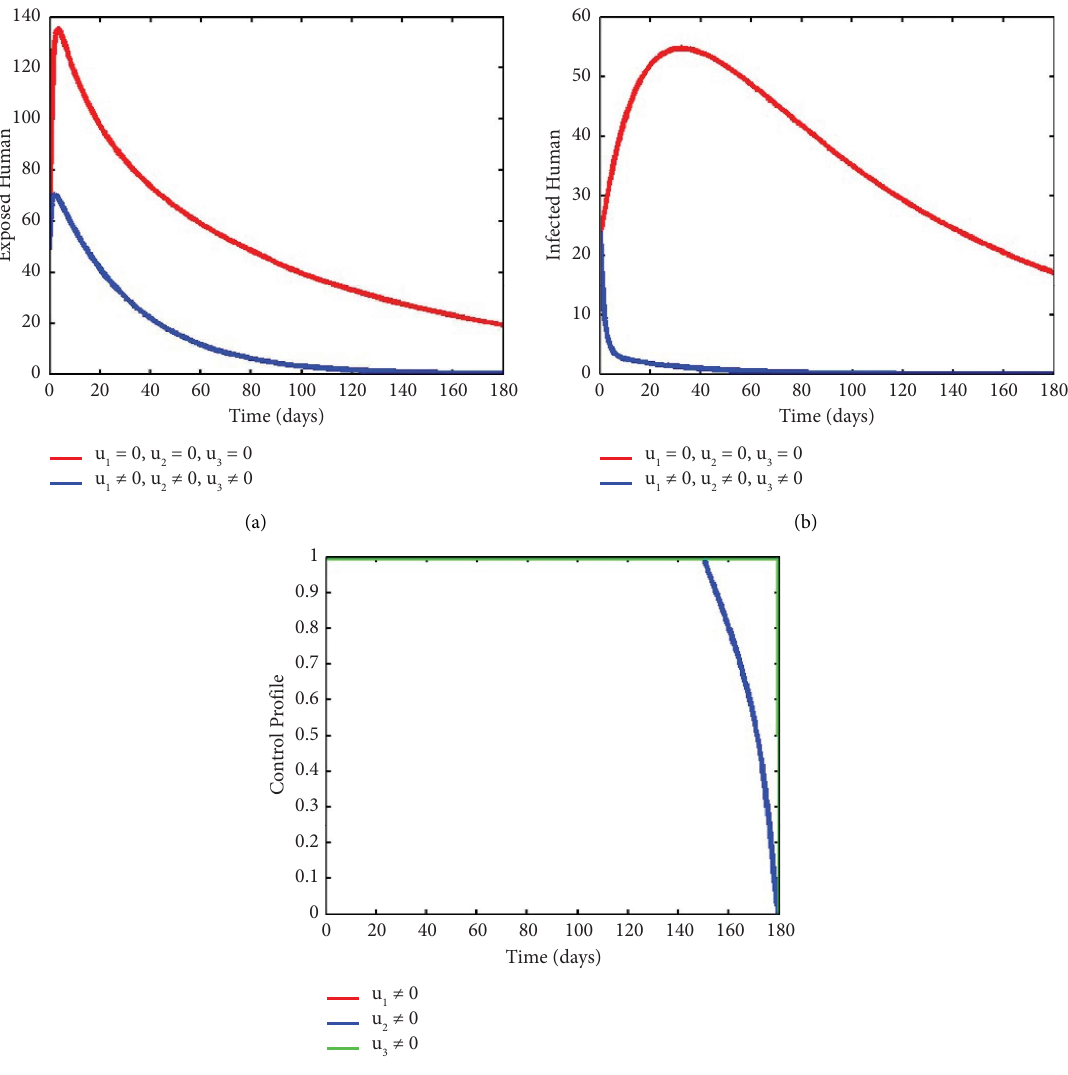
and treatment of infected u 2